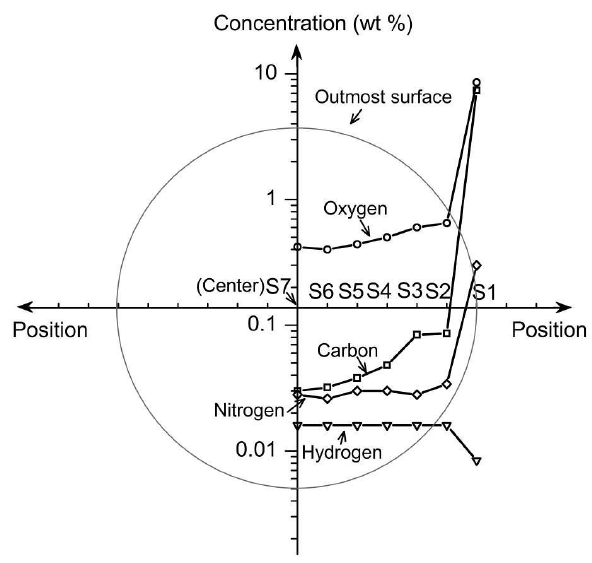
Figure 11. The distribution of interstitial contents at varied slices taken from different positions. Superimposed is the contour of the cylindrical compact. Although the high levels of impurities in the starting powder did not affect the densification of C.P. Ti, the resultant mechanical properties suffer significantly from the presence of these impurities.